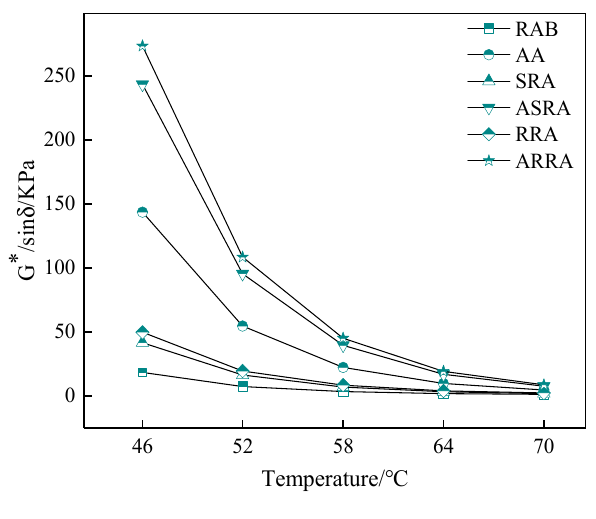
Figure 3. G*/sin δ .